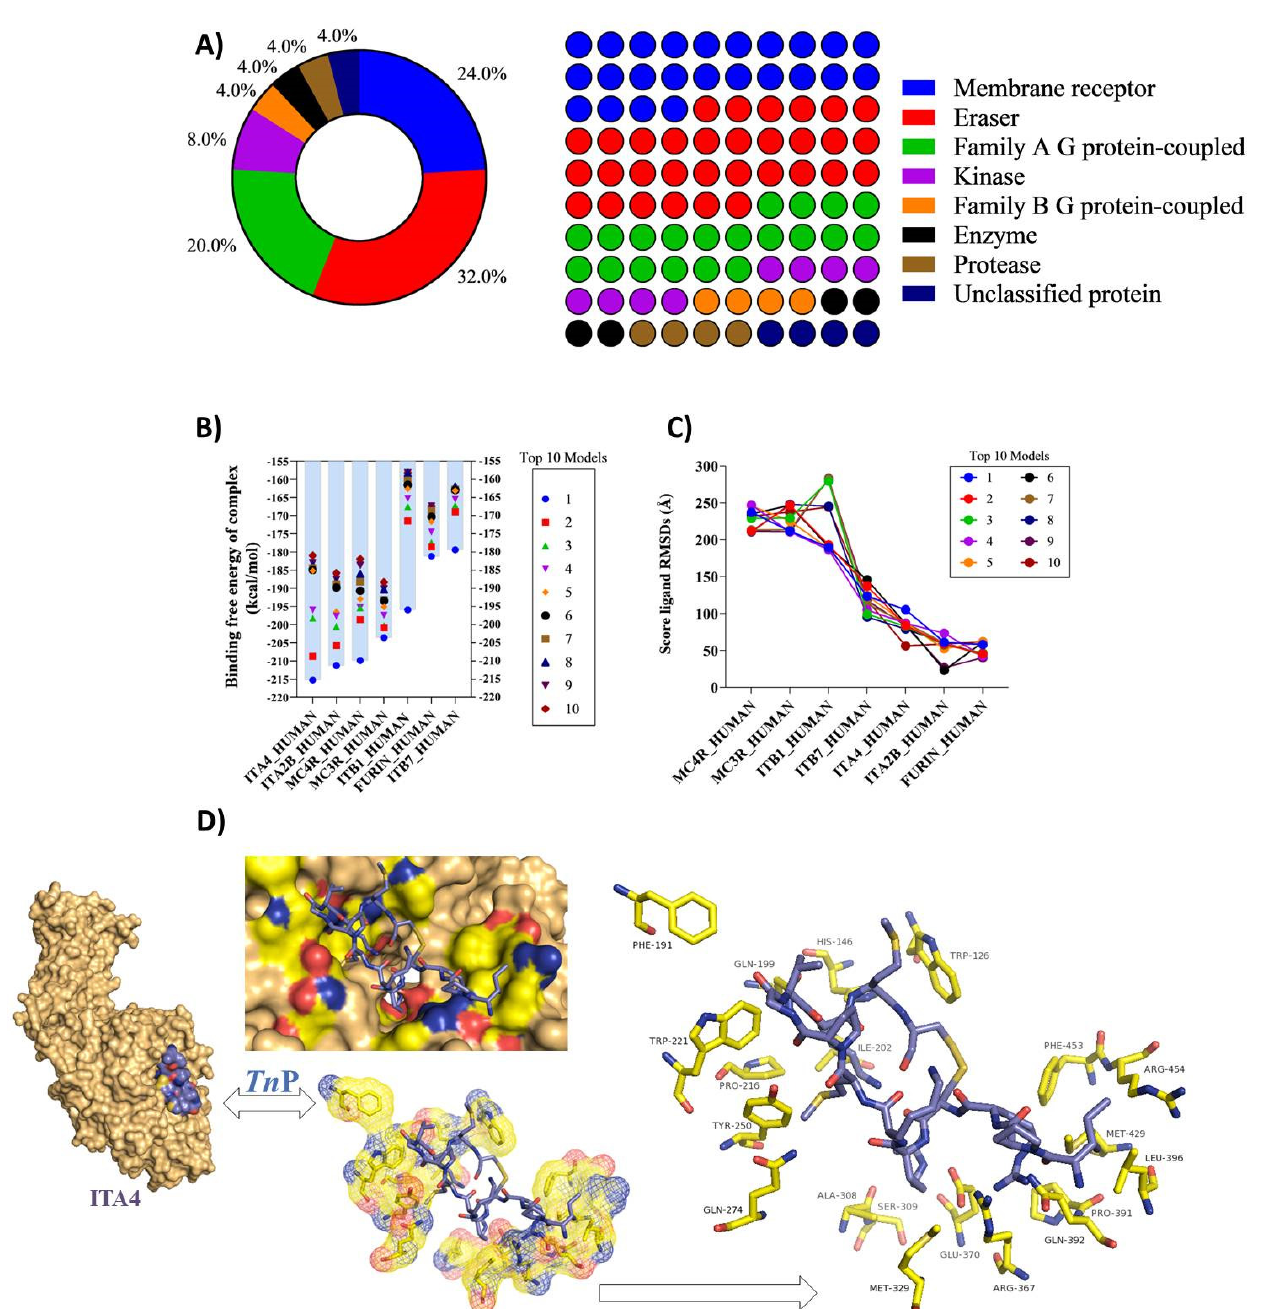
Figure 2. In silico Tn P–target protein interaction: ( A ) percentage and heat plot showing the main groups of human proteins/enzymes that interact with the Tn P predicate in SwissTargetPrediction; ( B ) free Energy of binding complex expressed in kcal/mol values of ten models simulated on the Hdock Serve platform (http://hdock.phys.hust.edu.cn/ accessed on 9 May 2022); ( C ) RMSD ligand score showing values in angstrom (Å) of the ten main models of simulated interaction with human molecules, and ( D ) the 3D structure of the Tn P/ITA4 complex and main ligand amino acids present in ITA4. The ITA4 PDB file was acquired from SWISS-MODEL (https://swissmodel.expasy.org/ repository/uniprot/Q3MU74 accessed on 9 May 2022) using the ITA4_HUMAN as